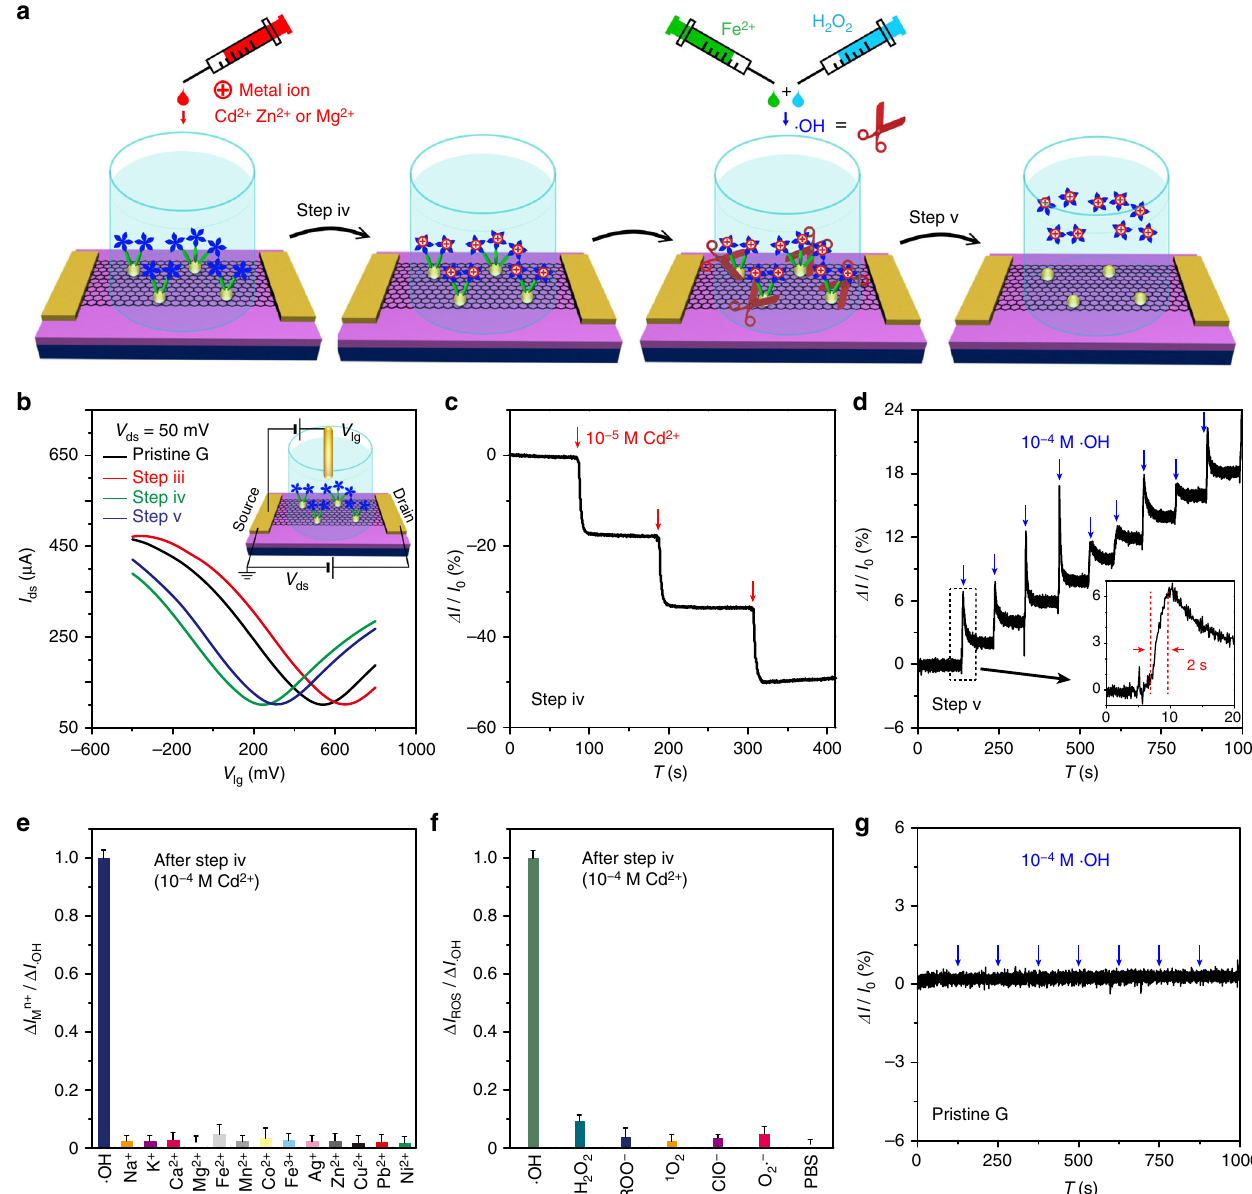
Fig. 2 Detection performance and mechanism of the fi eld-effect transistor (FET) sensor. a Schematic diagram of the (cid:129) OH detection. b Liquid gate transfer curves of a FET device of pristine graphene (black), after step iii (red), after step iv (10 − 4 M Cd 2 + , green), and after step v (10 − 4 M (cid:129) OH, blue), when liquid gate voltage ( V lg ) varies from − 400 to 800 mV. c , d Real-time electrical responses of a graphene/Au/Cys-PP FET device upon successive addition of 1 × 10 − 5 M Cd 2 + (step iv) and subsequent 1 × 10 − 4 M (cid:129) OH (step v). e Selectivity of a graphene/Au/Cys-PP-Cd 2 + FET sensor (modi fi ed in 10 − 4 M Cd 2 + ) toward (cid:129) OH (10 − 6 M) and metal ions (Na + , K + , Ca 2 + , Mg 2 + , Fe 2 + , Mn 2 + , Co 2 + , Fe 3 + , Ag + , Zn 2 + , Cu 2 + , Pb 2 + , Ni 2 + , 10 − 6 M). f Selectivity of a graphene/Au/Cys-PP-Cd 2 + FET sensor (modi fi ed in 10 − 4 M Cd 2 + ) toward (cid:129) OH (10 − 6 M) and other reactive oxygen species (H 2 O 2 , ROO − , 1 O 2 , ClO − , O 2 (cid:129) − , phosphate-buffered saline, 10 − 6 M). g The response of a pristine graphene channel (without modi fi cation) upon successive addition